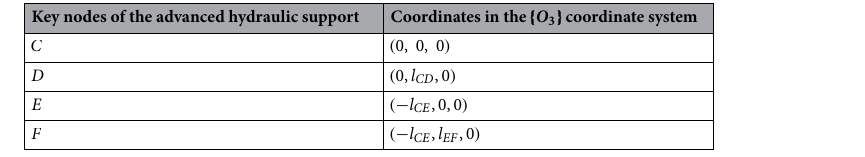
Table 5. Coordinates of nodes C , D , E , and F in the { O 3 } coordinate system.